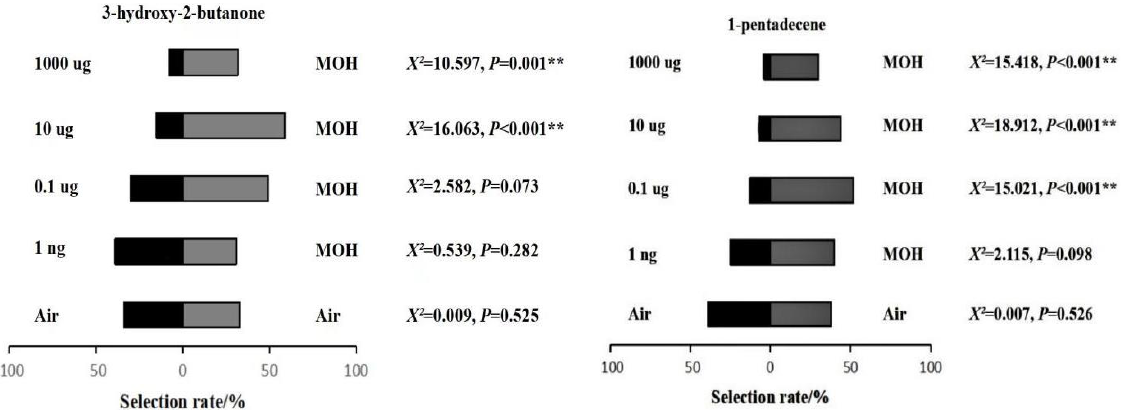
Figure 3. Mean behavioral responses (±) of S. granarius ( n = 10) to 3-hydroxy-2-butanone and 1-pentadecene. * and ** indicate significant difference at the 0.05 and 0.01 level, respectively.